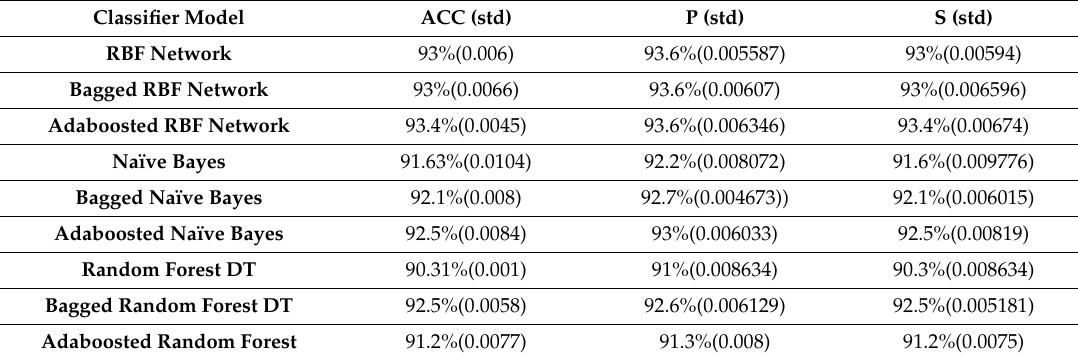
Table 4. Comparison of the classification results along with the standard deviation (std) of the individual classifiers and their ensembles.